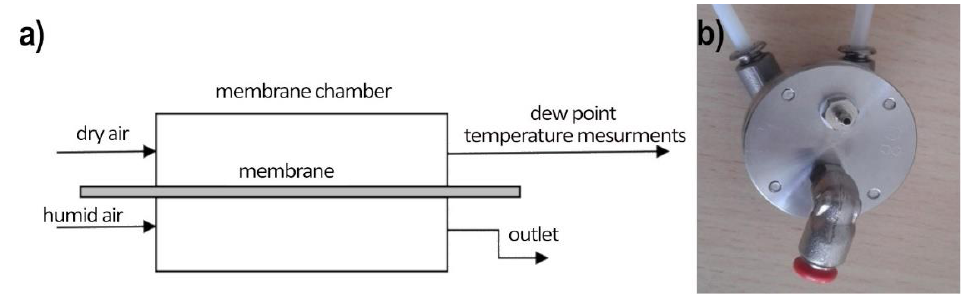
Figure 4. Measurement setup of water vapor permeation across membranes. ( a ) The scheme of the setup; ( b ) top view of the measurement chamber (wet side on the top, dry side on the bottom).